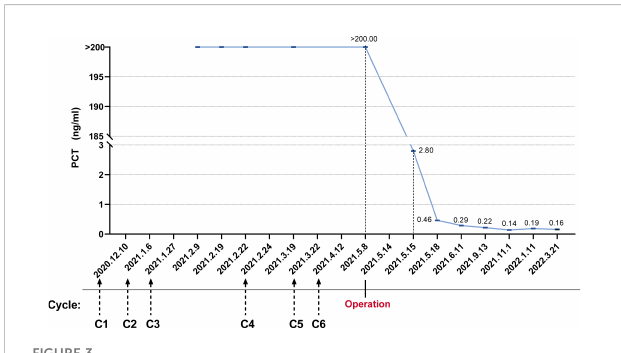
FIGURE 3 The trend of procalcitonin levels was from abnormally elevated initially to nearly normal after surgical resection.